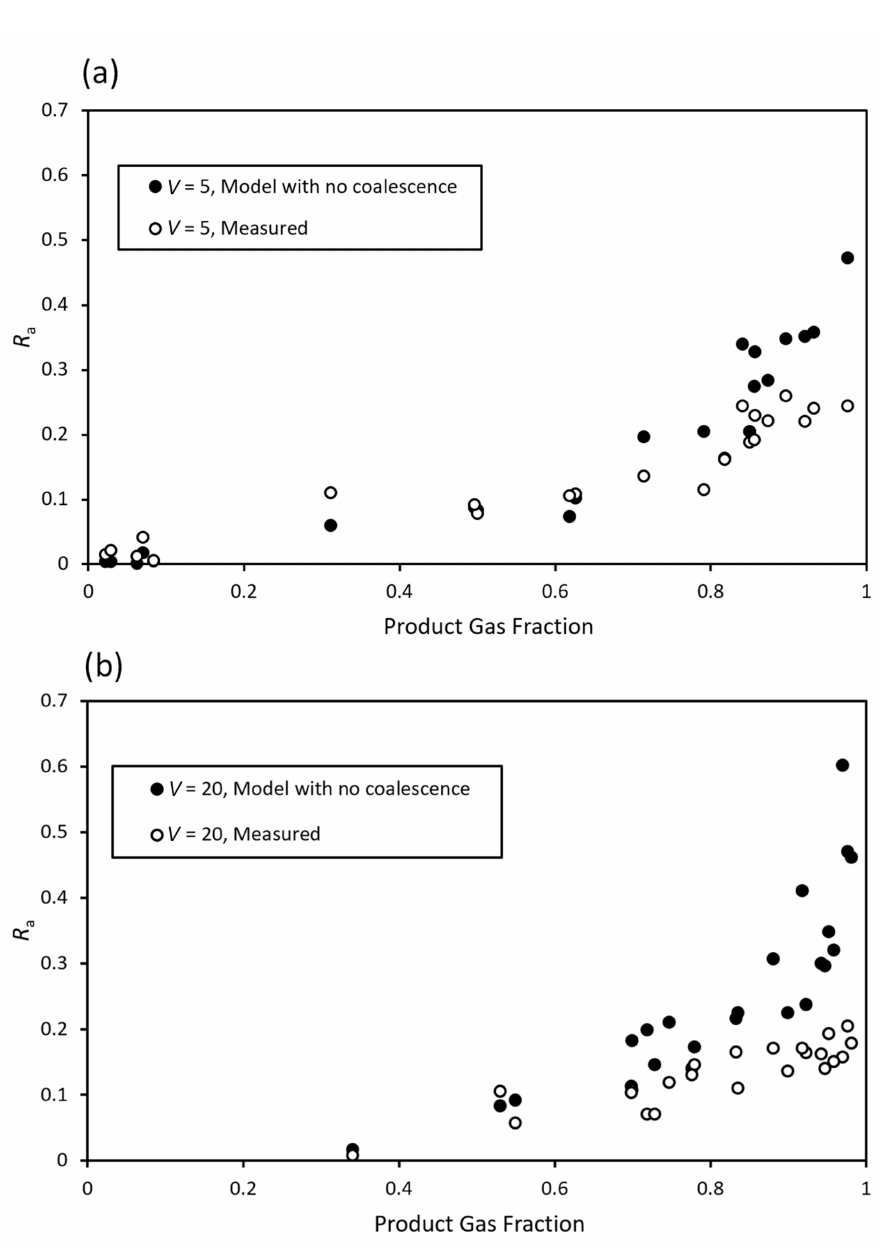
Figure 9. Measured adsorptive recovery vs. product gas fraction for ( a ) V = 5 and ( b ) V = 20, compared to the modeled results assuming no